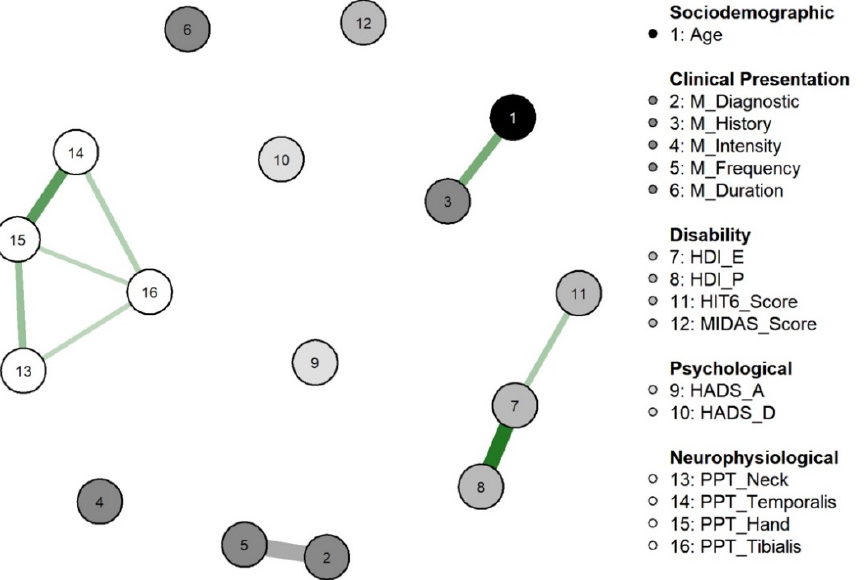
Figure 1. Network analysis of the association between demographic, migraine-related, psychological, and psycho–physical/neuro-physiological measures. Edges represent connections between two nodes and adjusted for the remaining nodes. Direction of the partial correlations were expressed as the color green for positive associations. The color Grey represents the association for categorical variables which no sign is defined. The thickness and color saturation of an edge denotes its weight (the strength of the association between two nodes). The node with the highest harmonic centrality was PPT at the tibialis anterior, followed by PPT at the cervical spine (Figure